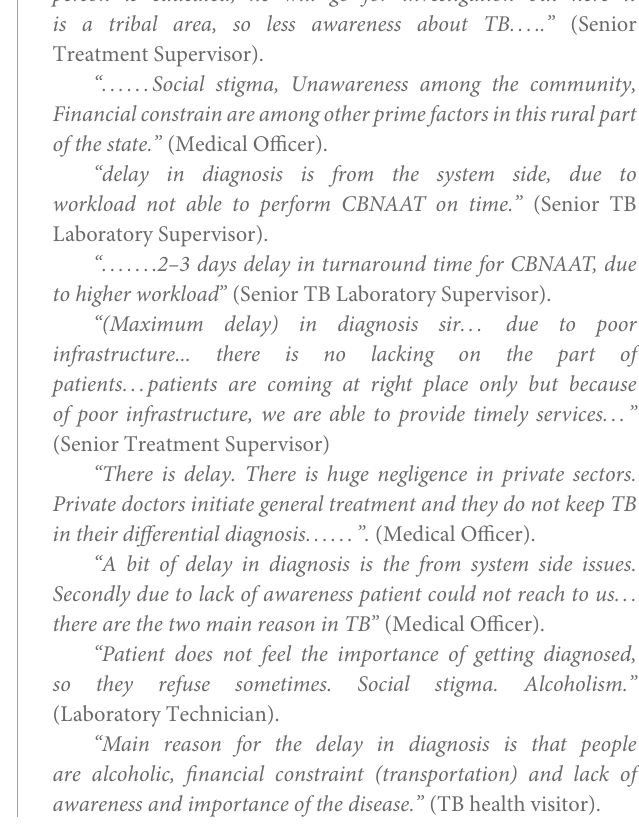
Table 6. Unawareness of free services for TB was also one of the risk factors in both categories, while illiteracy was only in pulmonary